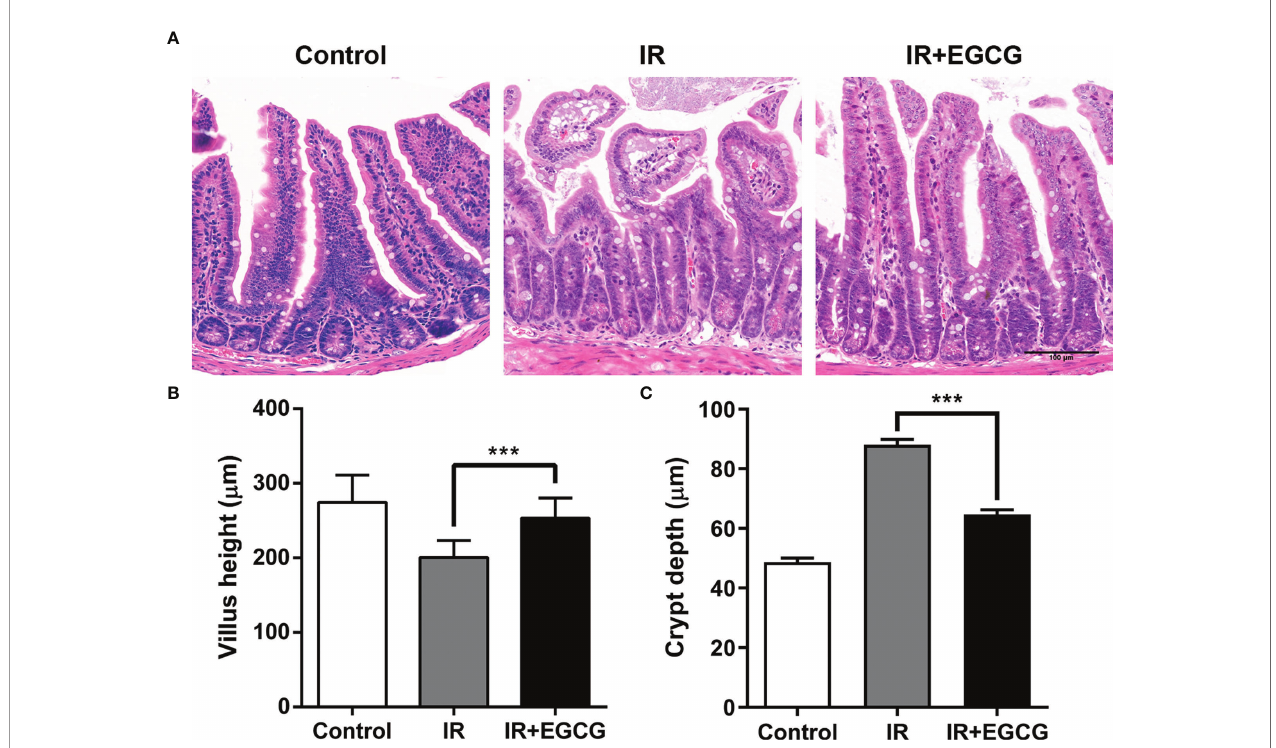
FIGURE 1 | EGCG attenuates radiation-induced intestinal injury in mice. (A) Representative H&E images of intestinal sections of the control and irradiated mice at 5 days after 9 Gy TBI (Scale bar = 100 m m). Bar graph showing the villus height (B) and crypt depth (C) in the indicated groups. All villi and crypts around a circumference were measured per sample. Results are presented as mean ± SEM. *** p < 0.001; n =